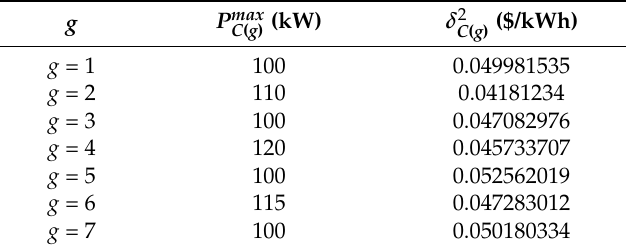
Table 6. Characteristics of distributed